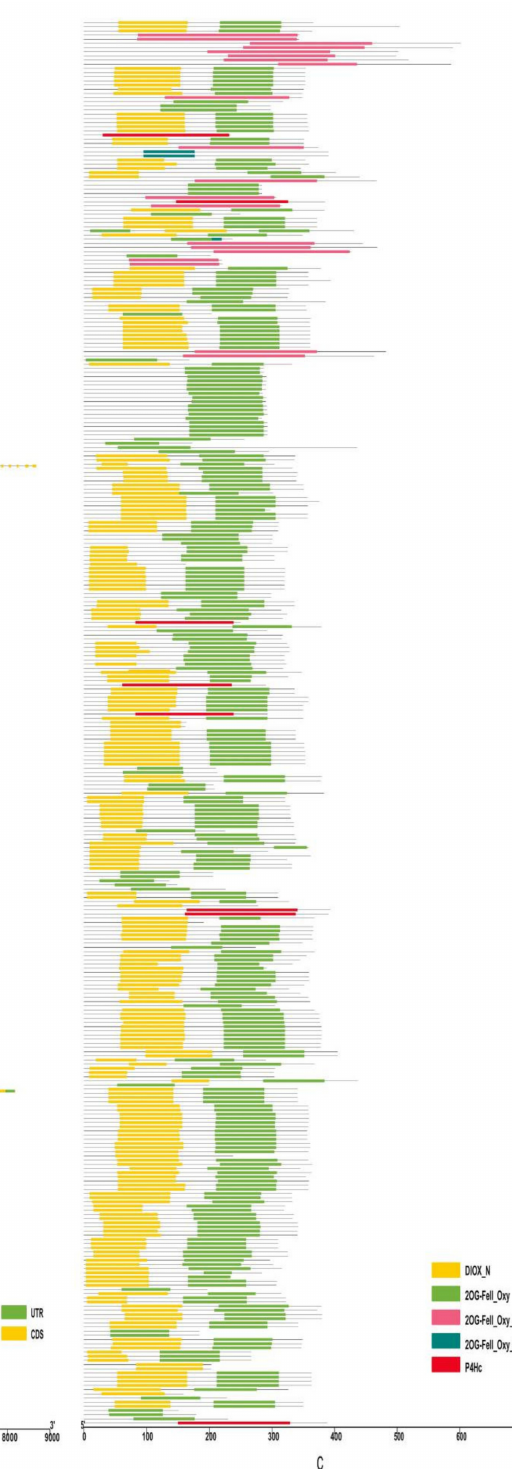
Figure 6. Phylogenetic relationships, gene structure, and domains in the 2OGD genes from B. napus . ( a ) The phylogenetic tree was constructed based on the full-length protein sequences of 2OGDsusing MEGA-X software. ( b ) Exon-intron structure of the 2OGD genes. Green boxes indicate untranslated 5 (cid:48) - and 3 (cid:48) - regions; yellow boxes indicate exons; and black lines indicate introns. ( c ) The domain composition of the 2OGD proteins. The domains DIOX_N and 2OG-FeII_Oxy. Some genes that only have 2OG-FeII_Oxy_2, 2OG-FeII_Oxy_3, or P4Hc are displayed in different coloured boxes. The length of proteins can be estimated using the scale at the